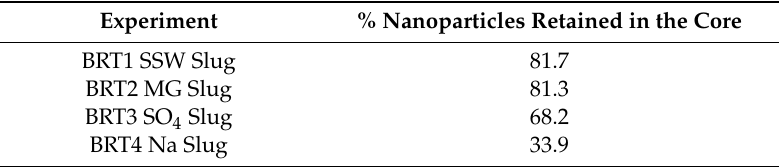
Figure 2. Nanoparticle (NP) and tracer concentrations from flooding of ( a ) BRT1; ( b ) BRT2; ( c ) BRT3; ( d ) BRT4. Table 3. Percent of nanoparticles retained / adsorbed in the